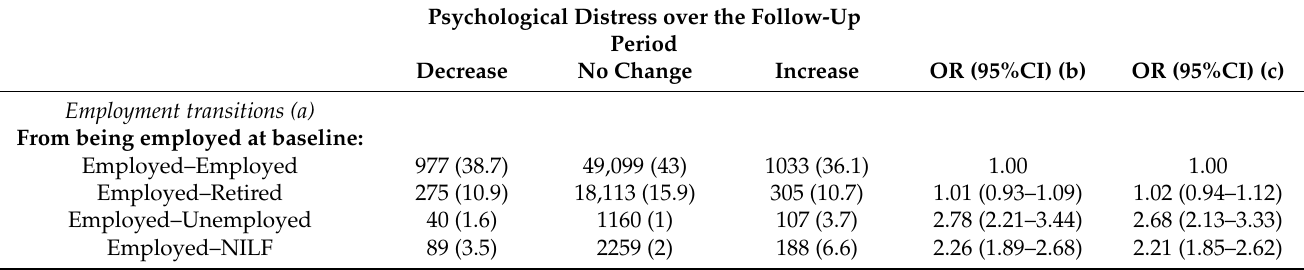
Table 2. Relative risk of psychological distress at follow-up by employment transitions and other study factors (6–9 years of follow-up, NSW 45 and Up Study,